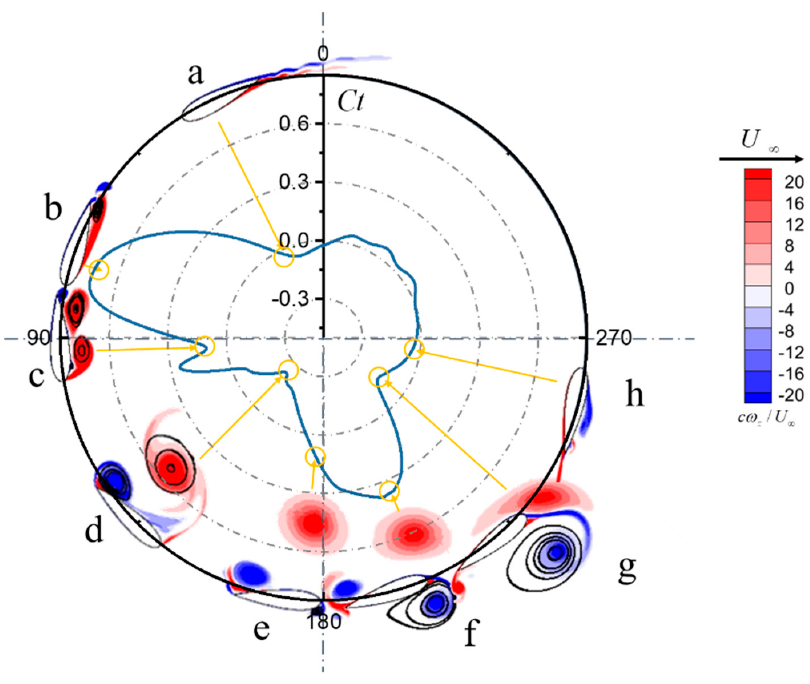
Figure 13. Tangential force coefficient of a blade and vorticity contours with λ = 1.5.